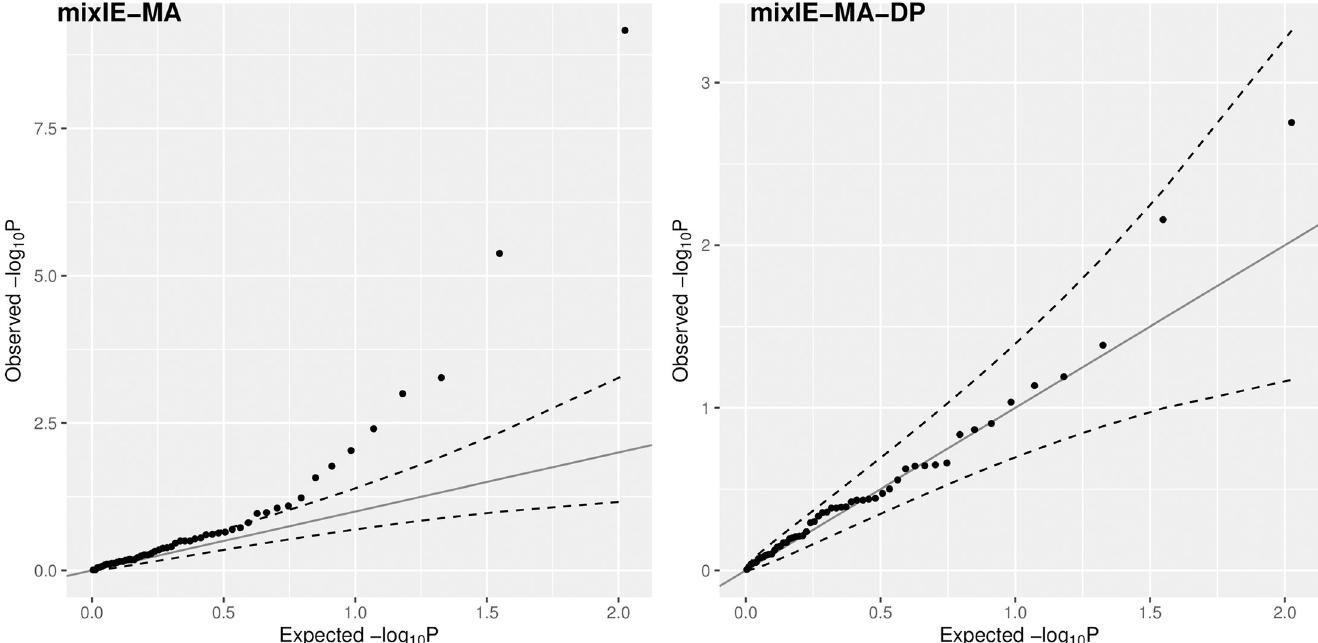
Fig 11. Q-Q plots for 53 (likely) null trait-pairs in the secondary real data examples. Left panel: mixIE-MA; right panel: mixIE-MA-DP.